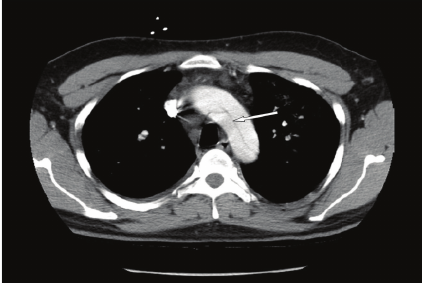
Figure 2: CT scan of chest prior to admission shows aortic dissection.